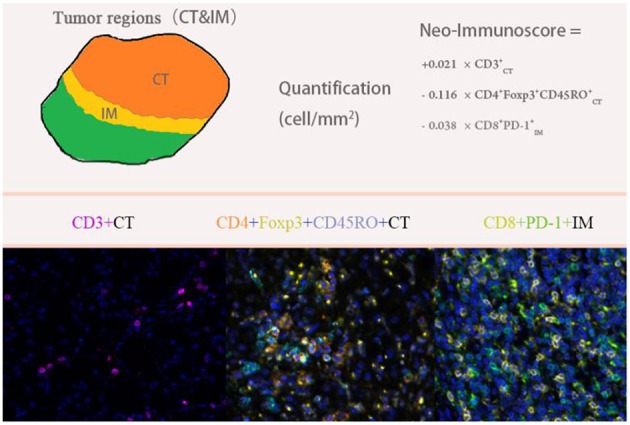
Neo-Immunoscore definition and methodology.